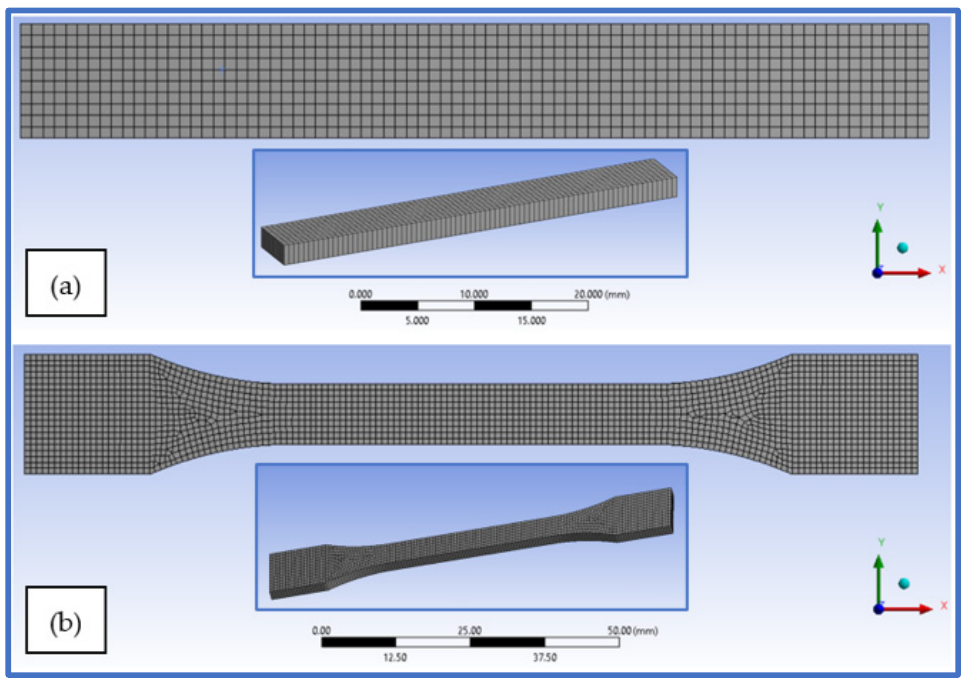
Figure 15. Hex-dominant mesh of the finite element specimen models—( a ) bending specimen, ( b ) tensile specimen.